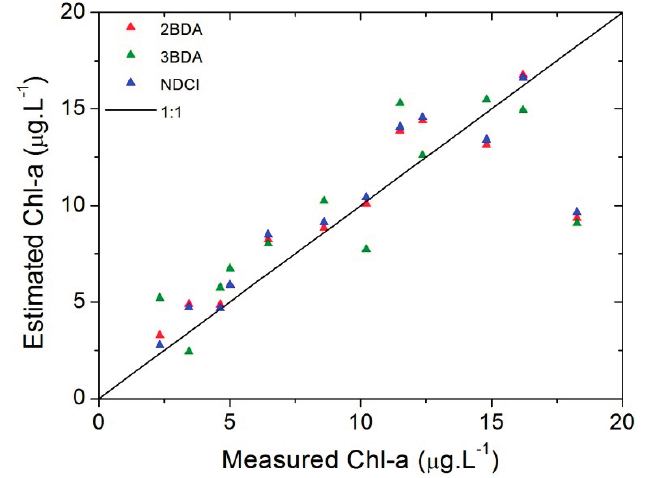
Figure 11. Scatterplots of the measured vs. estimated chl- a using OLCI simulated